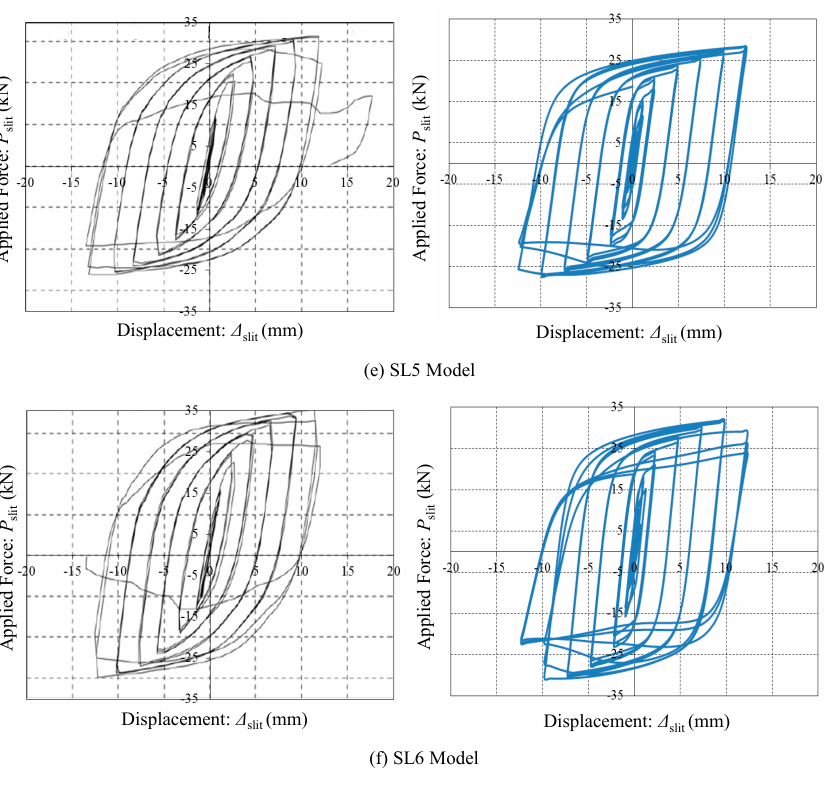
Figure 9. Applied forc0e vs. displacement curves for steel slit (SL) damper models, ( a ): SL1 Model; ( b ): SL2 Model; ( c ): SL3 Model; ( d ):SL4 Model; ( e ): SL5 Model and ( f ): SL6